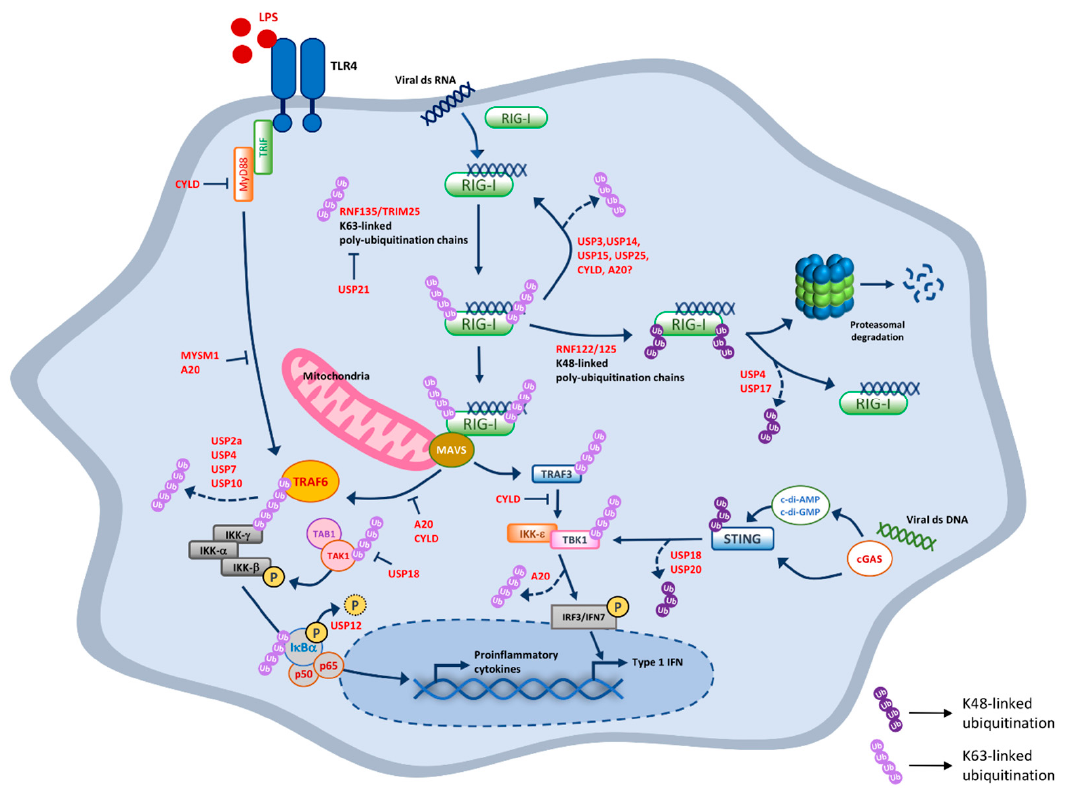
Figure 1. Regulation of the antiviral immune responses by ubiquitination in macrophages. After recognition of cytoplasmic viral RNA species, TLRs and RLRs signals through the downstream adaptors MyD88 / TRIF and MAVS, respectively. The MyD88 / TRIF adaptor then propagate TLR signal to TRAF6 and NF- κ B (p50 and p65) activation. K63-linked polyubiquitination recruits the TAK1 / TAB1 complex, which leads to phosphorylation of I κ Ba. Degradation of I κ B α by phosphorylation releases the p50 and P65, leading to induction of proinflammatory cytokines. RLRs signals via the mitochondrial adaptor MAVS are strictly regulated by K63- and K48-linked polyubiquitination. RIG-I is activated by K63-linked polyubiquitination mediated by TRIM25, which is inhibited by USP21. On the other hands, RNF125-mediated K48-linked polyubiquitination of RIG-I induces its degradation by the proteasome, which can be inhibited by USP4 and USP17. The cytoplasmic viral DNA can be recognized by cGAS, which activates STING via synthesizing the second messenger (c-di-GMP and c-di-AMP) and K48-lined ubiquitination. Activated STING facilitates type I IFN gene expression. Dark purple circles indicated K48-linked ubiquitination and light purple circles indicate K63-linked ubiquitination. The details of how specific DUBs regulates the activities of the TLRs and RLRs signaling molecules are described in the